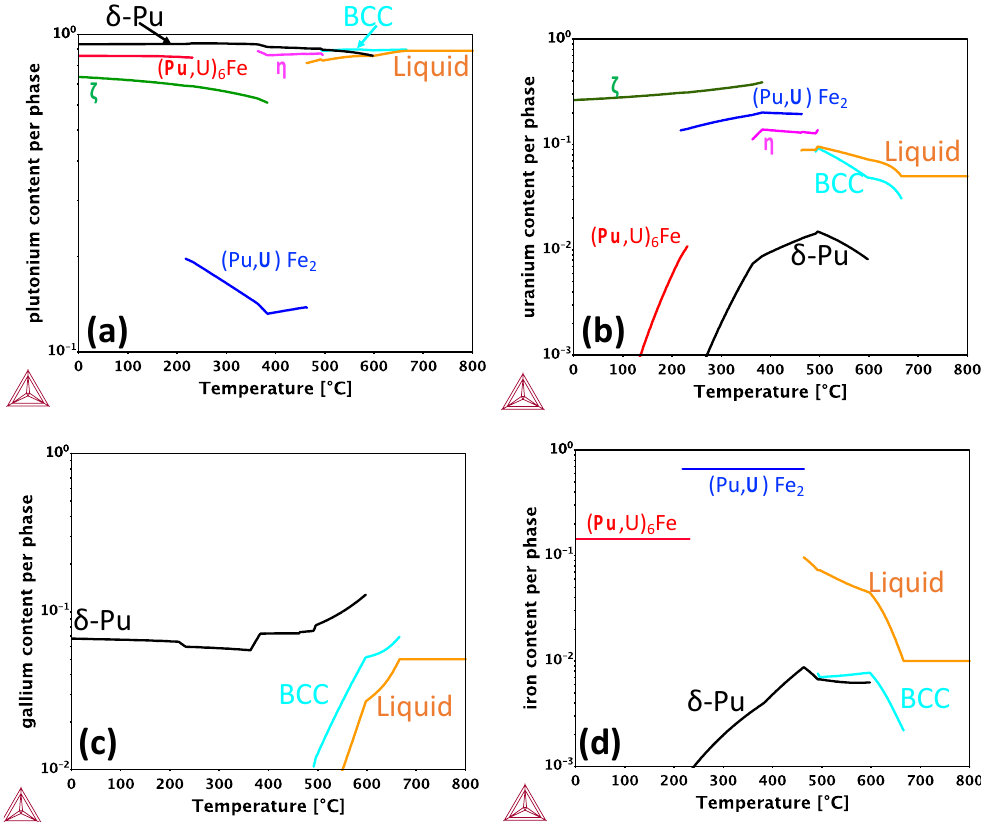
Figure 11. Distribution of elemental components within a given phase for the Pu 89 -U 5 -Ga 5 -Fe 1 for ( a ) plutonium, ( b ) uranium, ( c ) gallium and ( d ) iron.